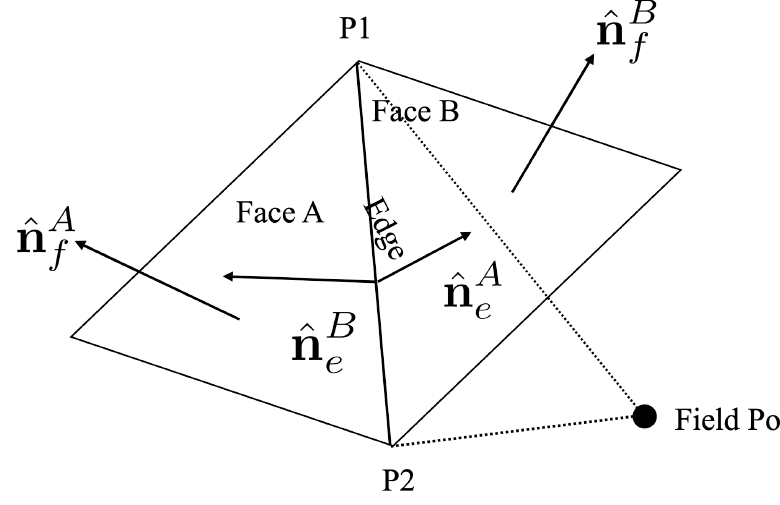
Figure 3. Polyhedron facets and